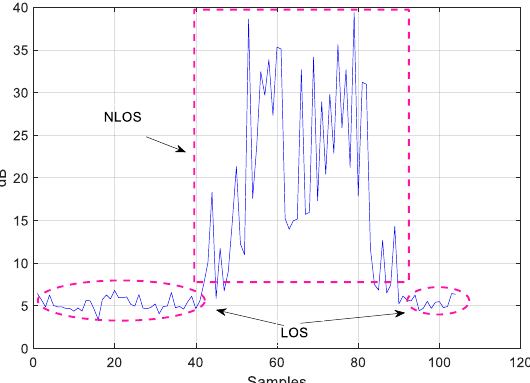
Figure 3. The difference between the received power and signal power in the first path.